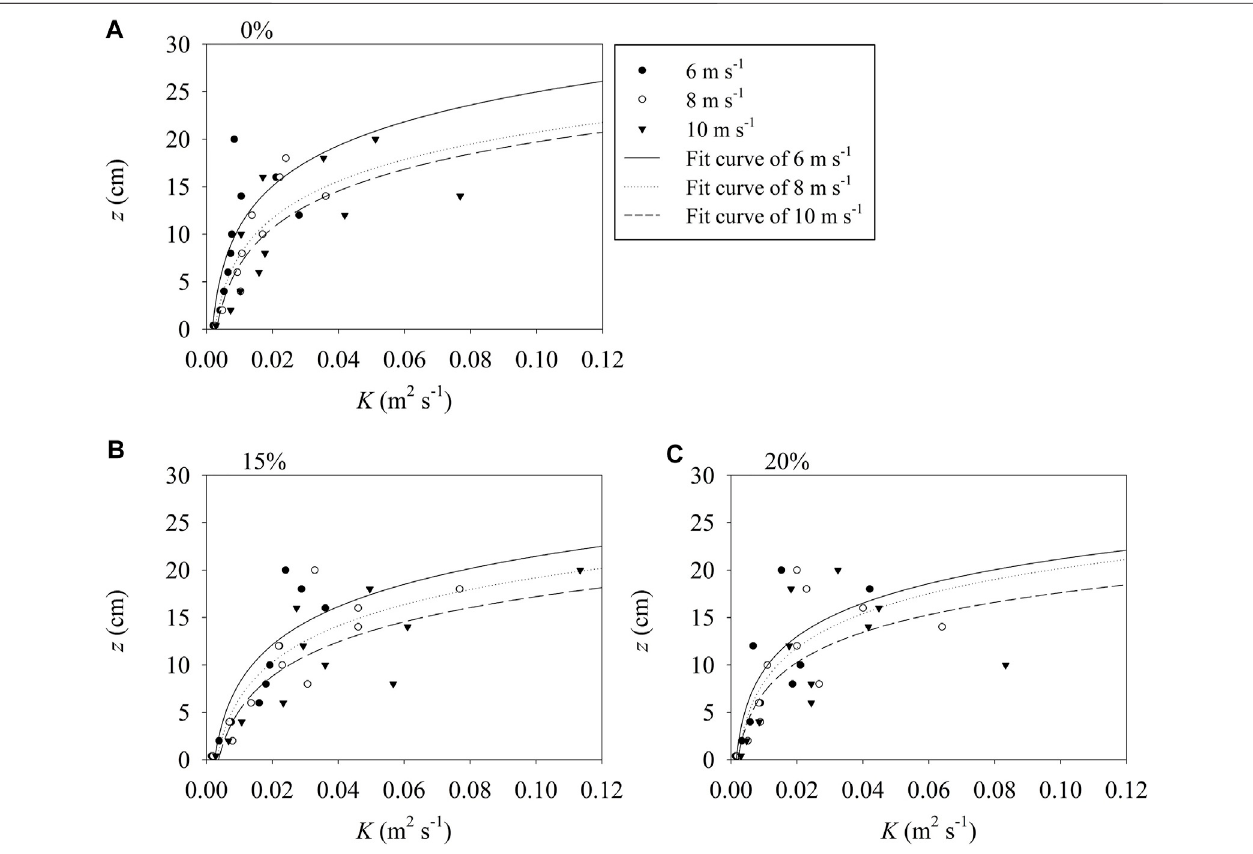
FIGURE 10 | Variation of turbulent transfer coef fi cient K with height at gravel coverages of (A) 0%, (B) 15%, and (C) 20%.